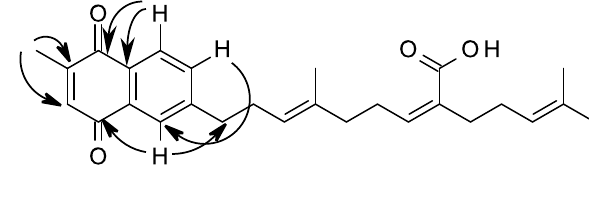
Figure 2. Key HMBC correlations for 10.